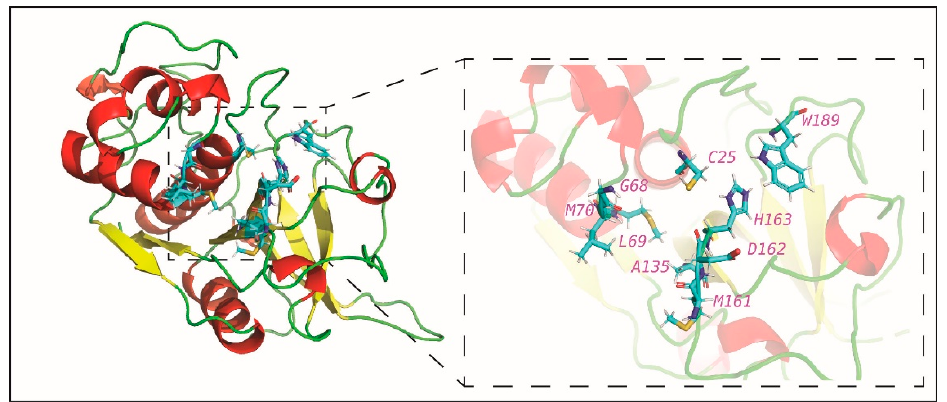
Figure 3. Cartoon representation of the crystal structure of human cathepsin L (PDB 5MQY). The figure zooms into the region containing the catalytic residues Cys (C25) and His163 (H163) in the S1 subsite, residues Asp162 (D162), Met161 (M161), Ala135 (A135), Met70 (M70) and Leu (L69) in the S2 subsite, Trp189 (W189) at the centre of S1 ′ subsite and the conserved residue Gly68 (G68) in the S3 subsite of the enzyme.